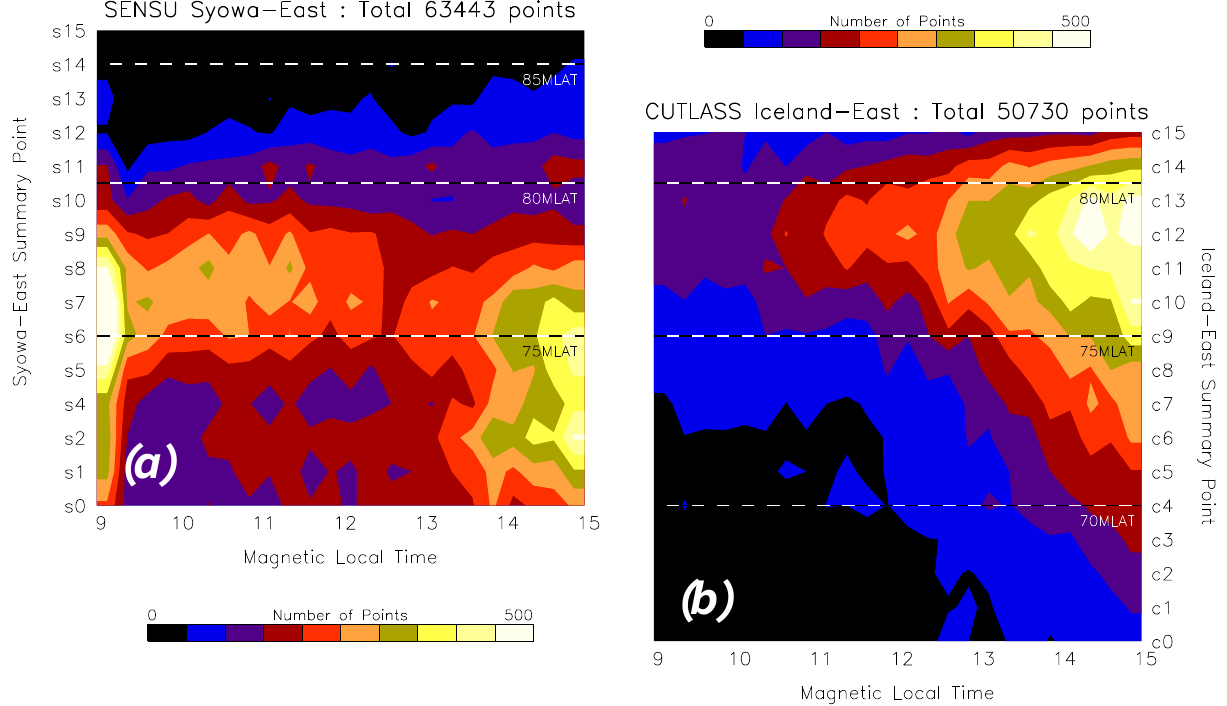
Fig. 3. Color-coded number of data points as a function of magnetic local time obtained by (a) SENSU Syowa-East radar and (b) CUTLASS Iceland-East radar during the interval of our statistical analysis. The vertical axis indicates the summary points from S0 to S15 for Syowa-East and C0 to C15 for Iceland-East, and the horizontal axis is the magnetic local time from 09:00 to